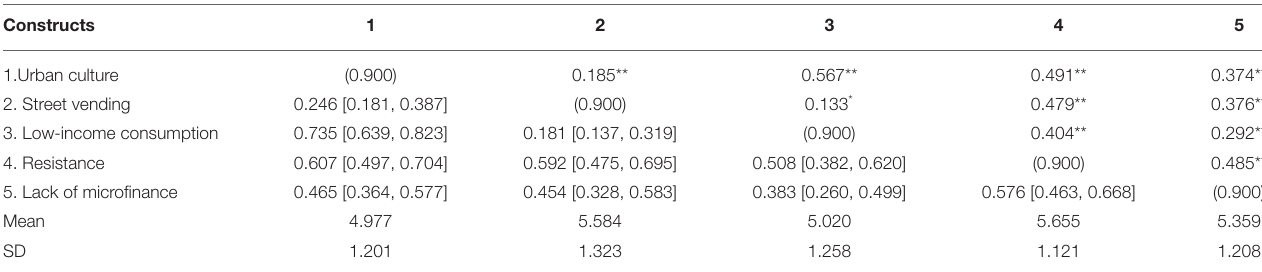
TABLE 2 | Assessment of discriminant validity using HTMT.